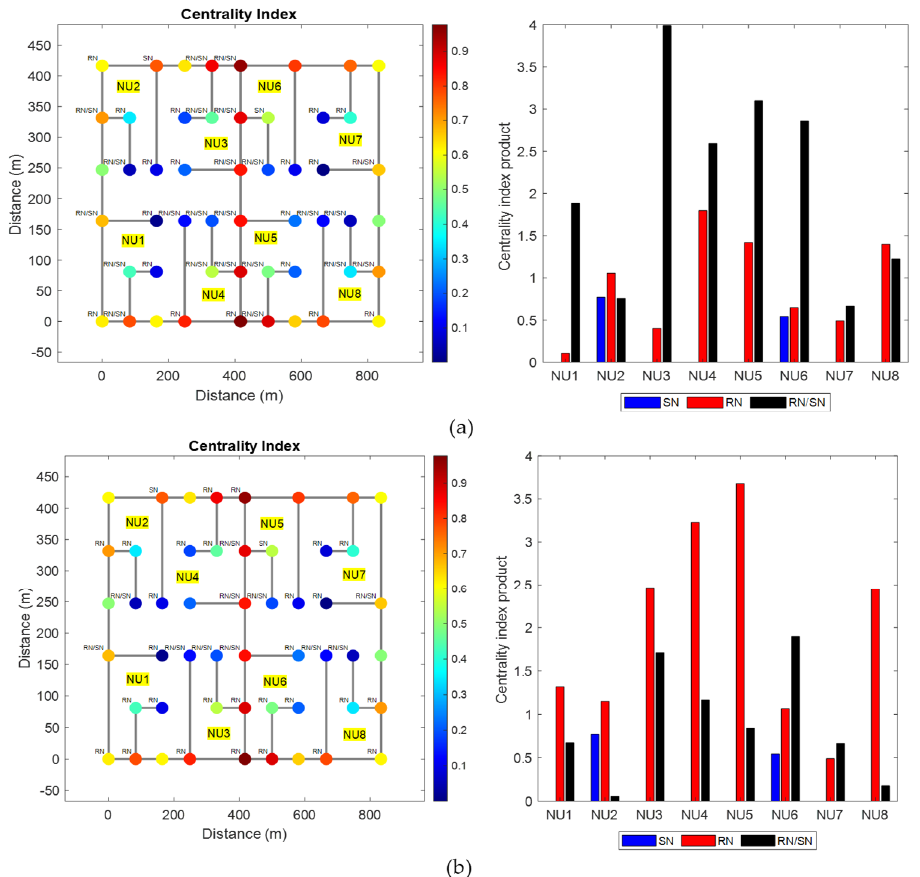
Figure 7. Centrality analysis of combination C 1 ( a ) for scenarios S1-A and S1-B, ( b ) for scenarios S1-C and S1-D with updated layout.